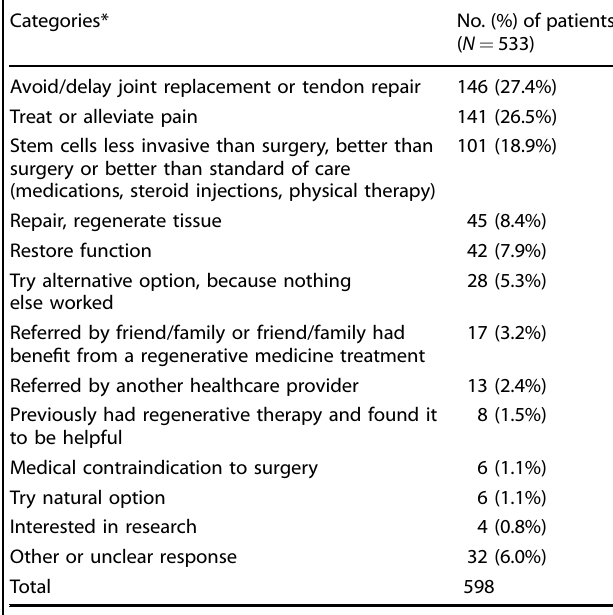
Table 1. Reasons why patients reported that they were interested in a SCT for their